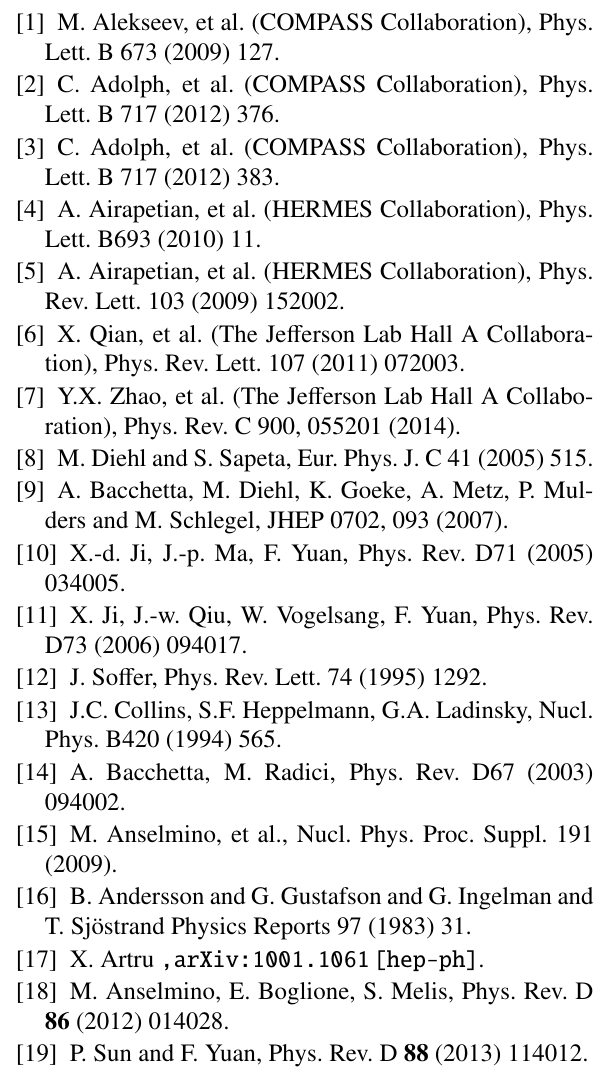
Figure 14. Hall A measurements of A cos( φ h − φ s ) ing some hint of non zero asimmetries, more evident for π −